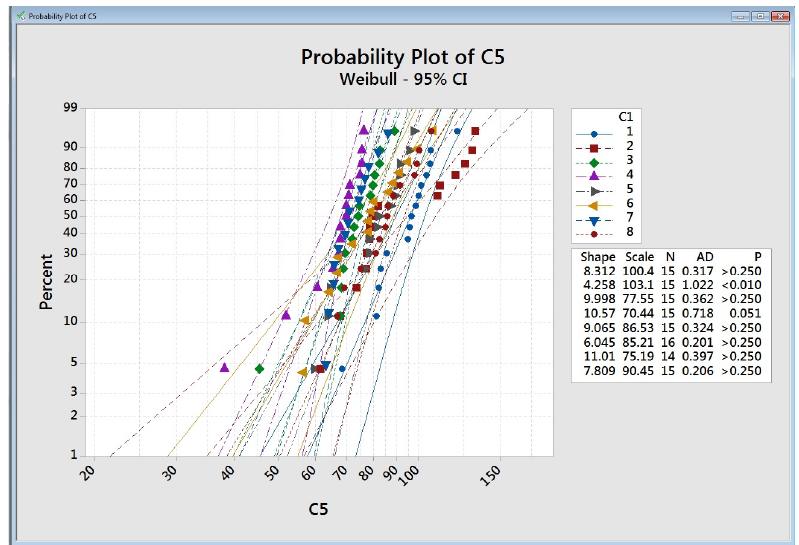
Figure 4. Weibull parameters (shape and scale) of the various tested ceramics groups CR, IV, NR, and VT, mixed with H 2 O or their corresponding modeling liquids.